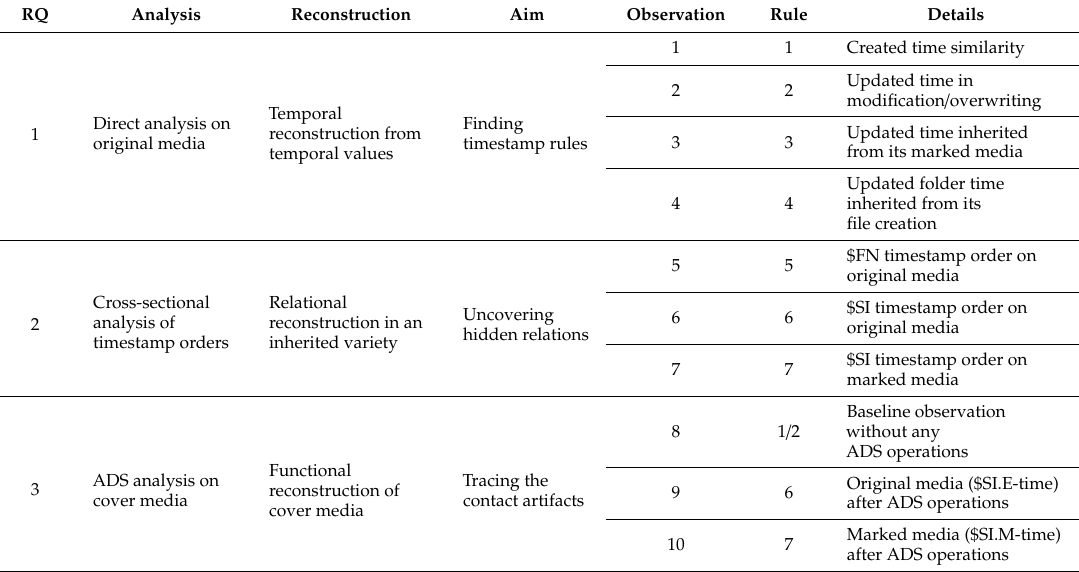
Table 9. Reconstructions on timestamp